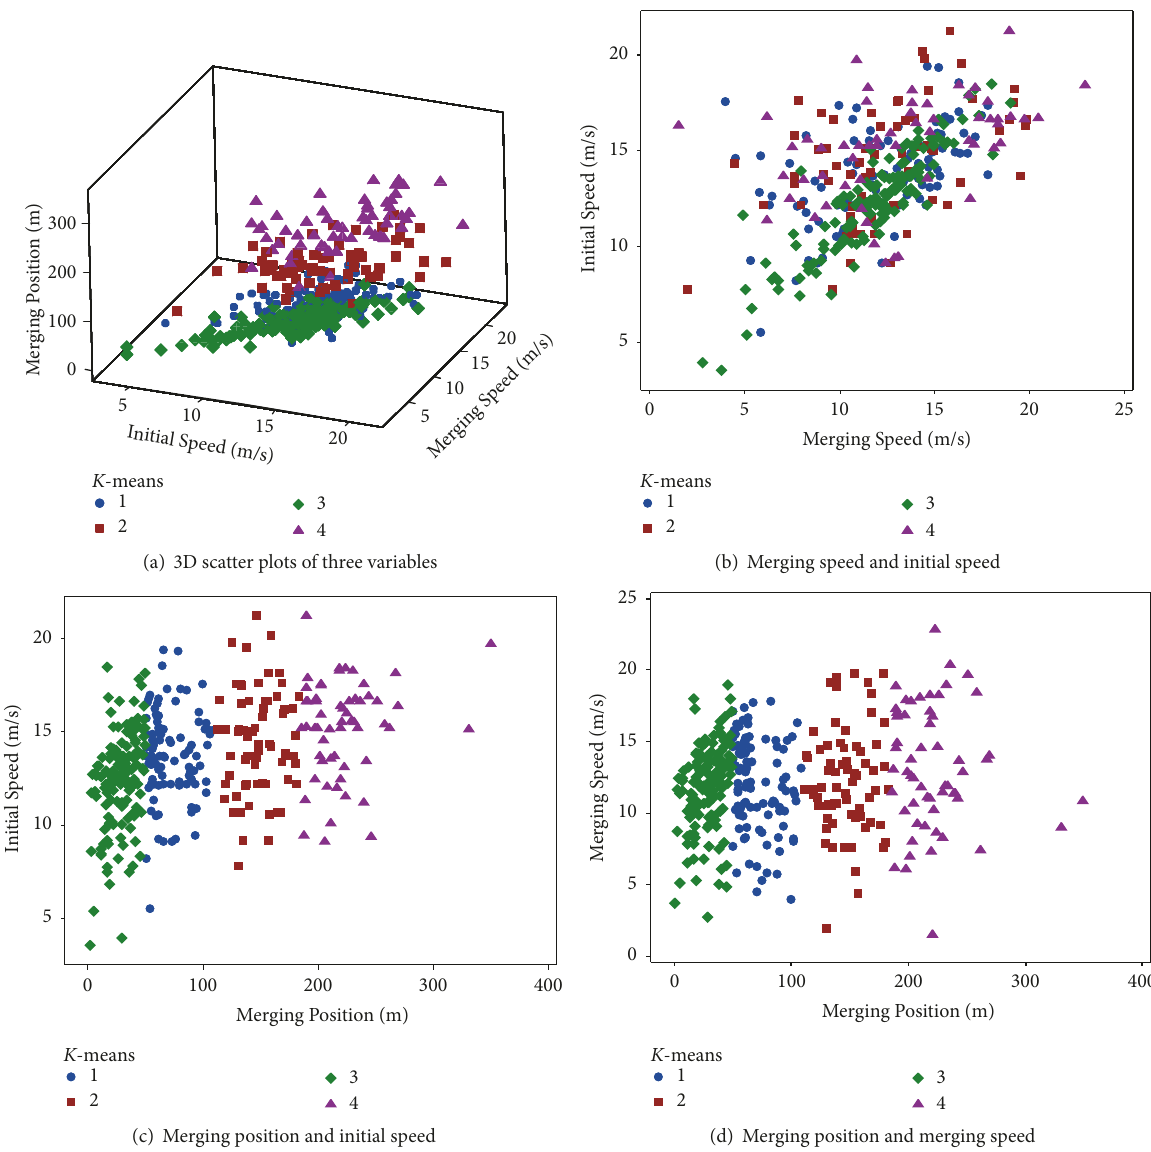
Figure 3: 3D scatter plots and 2D scatter plots of 𝐾 -means clustering